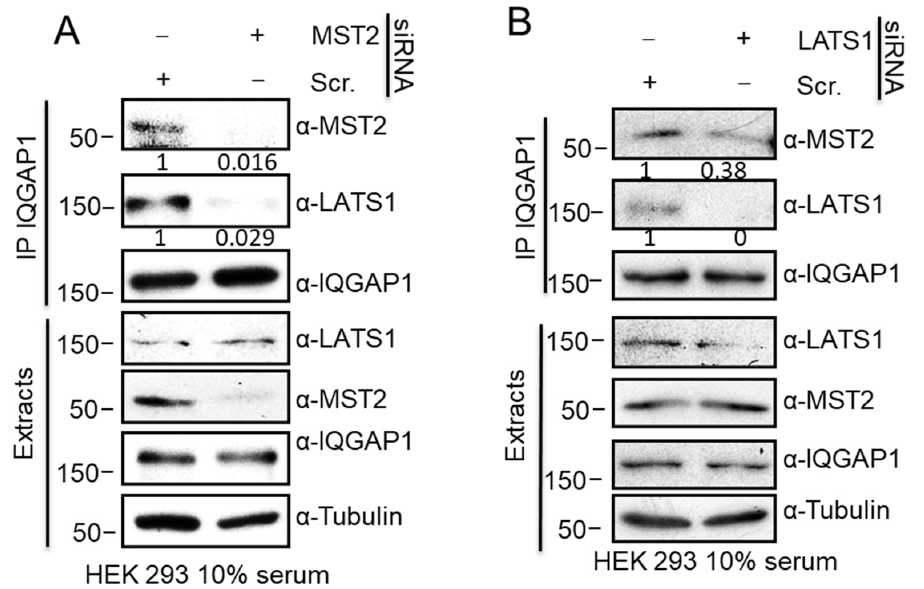
Figure 4. MST2 regulates LATS1 interaction with IQGAP1. ( A ). HEK 293 cells were transfected with MST2 siRNA or a non-targeting (Scr) siRNA pool. Cells were lysed after 48 h and IQGAP1 immunoprecipitates were examined by western blotting. ( B ) HEK 293 cells were transfected with LATS1 siRNA or a non-targeting siRNA pool. IQGAP1 immunoprecipitates were examined by western blotting. IP blots were quantified using ImageJ and the numbers show the relative fold change of MST2 or LATS1 normalised by IQGAP1